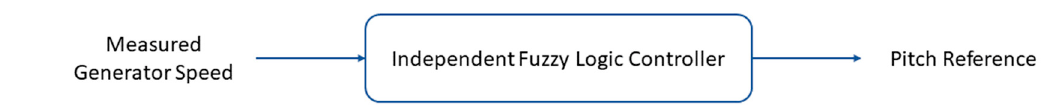
Figure 5. Simplified block diagram of the Independent Fuzzy Logic Controller.